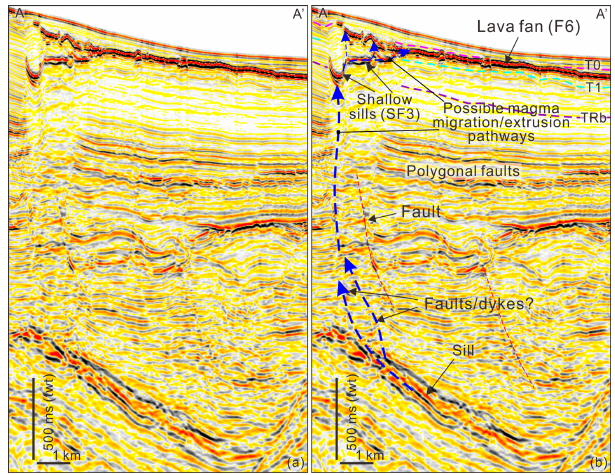
Figure 6. (a) The seismic profile and (b) its interpretation show a magma pluming system from a deep-seated sill, shallow sill (S1), and lava fan (F6). See location of seismic profile A–A’ in Fig. 5a.